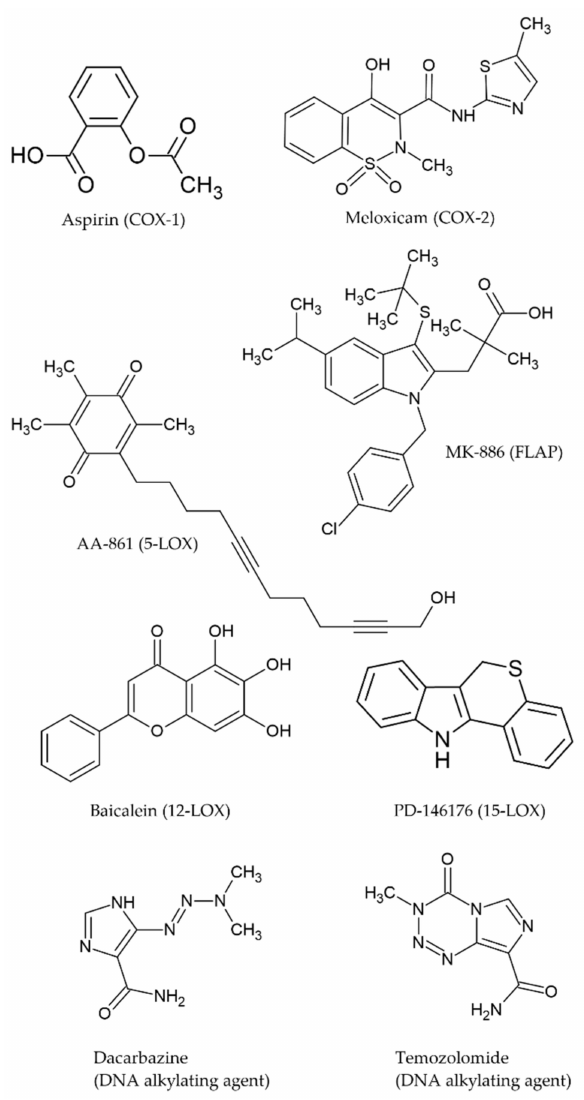
Figure 1. Chemical structures of the selected COX/LOX inhibitors and chemotherapy drugs (from MDL mol files downloaded from ChemSpider and processed with ACDLabs